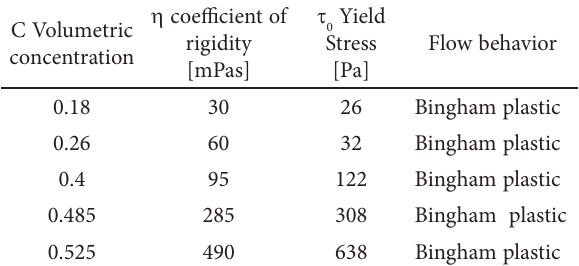
Table 11. Flow properties of base metal tailing,